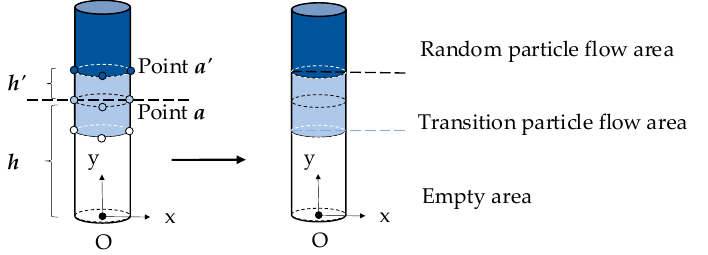
Figure 6. Particle flow emission region delineation. O is the coordinate origin . A dividing line is made through point a , which is parallel to the x-axis at a distance h . For the empty area, part of the vertices are marked with the color white, the random particle flow area vertices are marked with black, and the transition particle flow area takes two color transition values. It is worth noting that the number of leaf particles in the